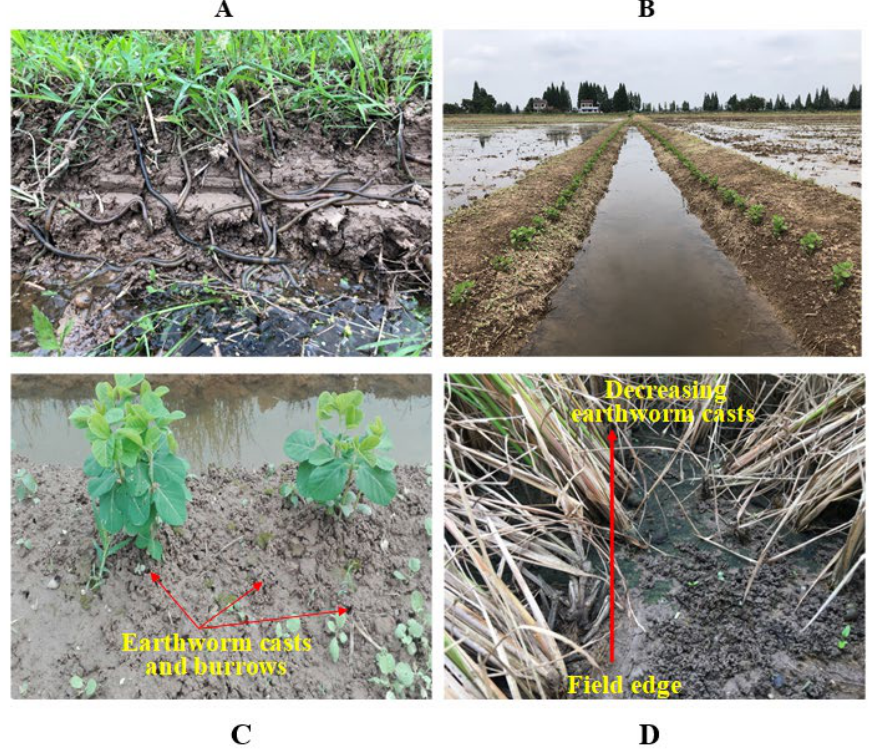
Figure 1. Earthworms migrated between field margins (FM) and arable field (AF). ( A ): Earthworms migrated forward FM after applying flooding. ( B ): Planting soybean in FM. ( C ): Earthworm casts and burrows in FM after applying flooding. ( D ): Earthworms migrated from FM to adjacent AF in September.